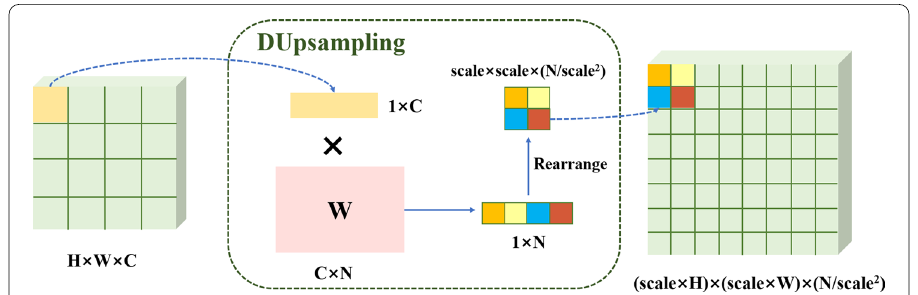
Fig. 6 Structure of DUpsampling, scale denotes the up-sampling ratio, W is the inverse projection matrix and N is the dimension of